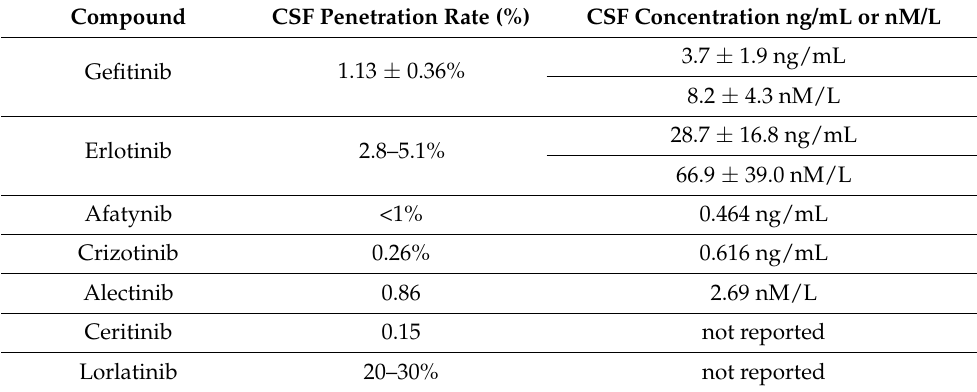
Table 3. Concentrations of the EGFR and ALK tyrosine kinase inhibitors in the cerebrospinal fluid